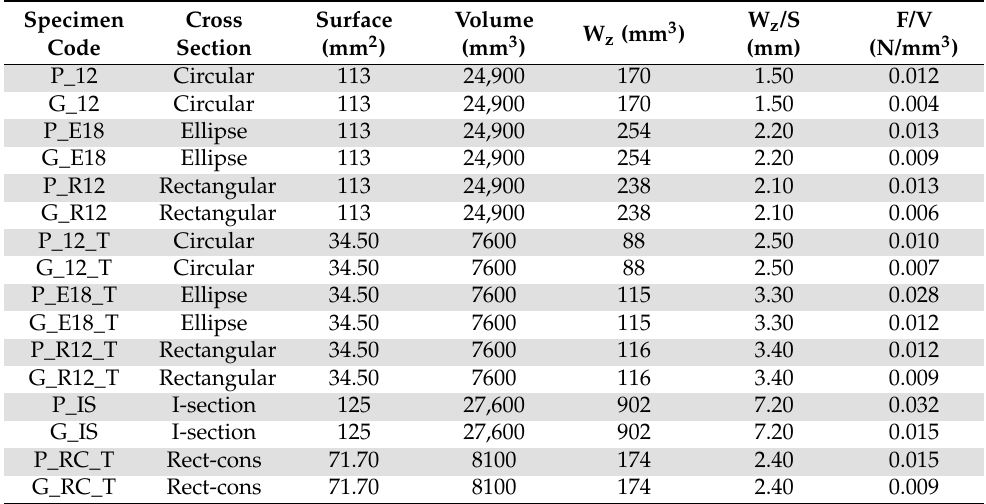
Table 3. Efficiency of the specimen